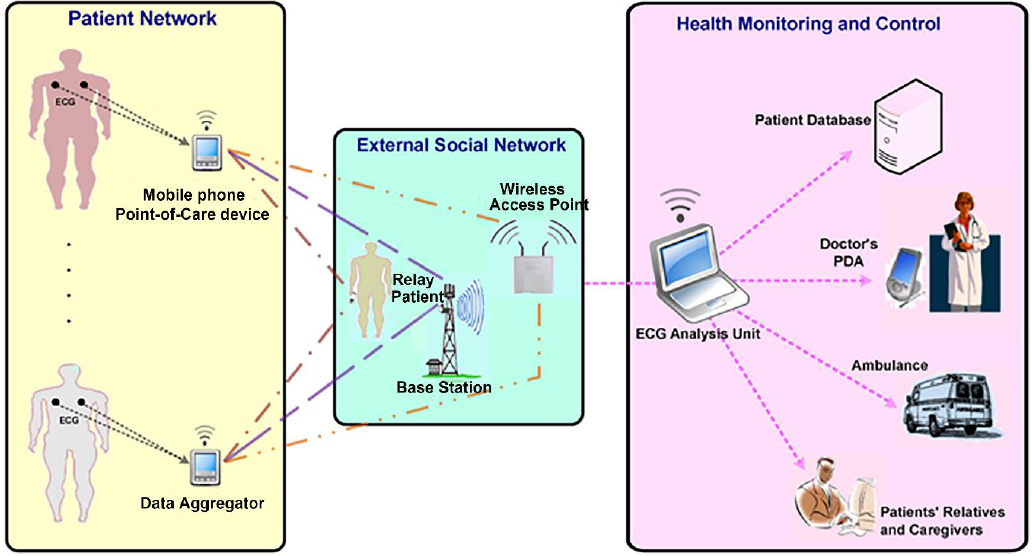
Figure 6. A wireless ECG monitoring system for E-health applications (reproduced with permission from the authors of [166]).